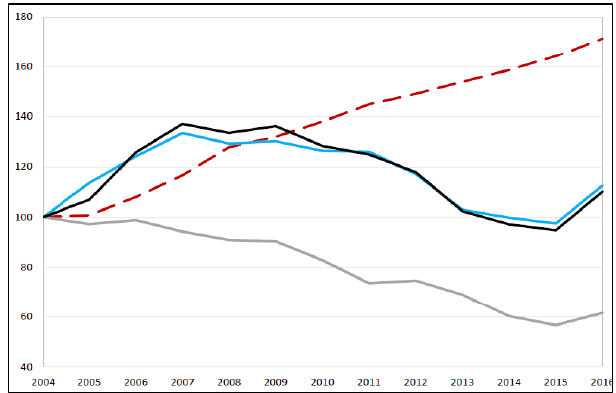
Fig. 2. Changes in emissions of NO x , CO and particulate matter PM 2,5 from road transport in Poland in the years 2004-2016 in relation to the change in the number of cars and tractors, assuming that the volume of emissions in 2004 = 100% (Legend: red line – percentage change in the number of cars and tractors, blue line – percentage change in NO x emis- sions from road transport, grey line – percentage change in CO emissions from road transport, navy blue line – percentage change in PM 2.5 emissions from road transport)